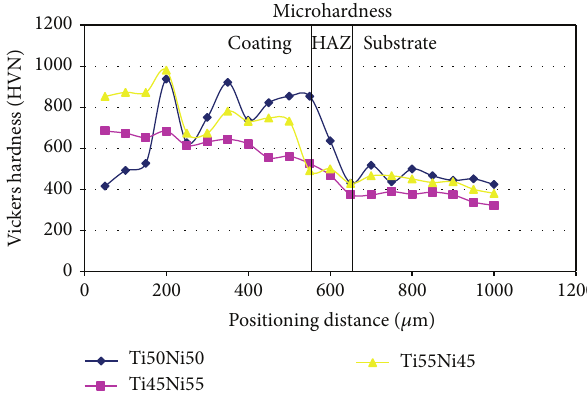
Figure 8: Microhardness measurement of laser deposited coatings.